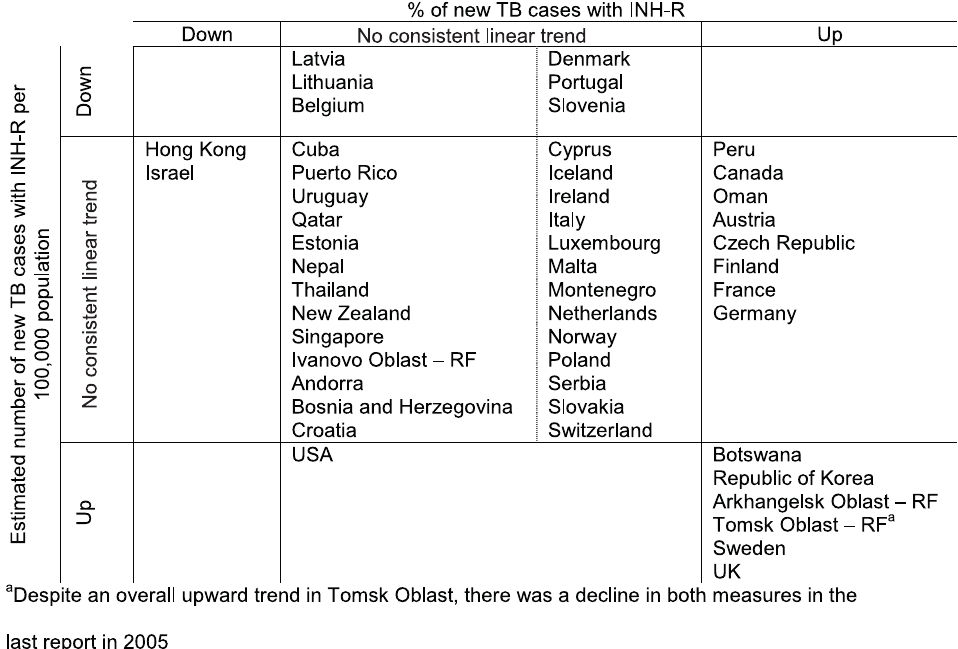
Figure 3. Linear trends in isoniazid resistance (INH-R) among new TB cases. We estimated trends in the percentage of new TB cases with INH-R and the estimated number of new TB cases with INH-R per 100,000 population. Settings are grouped by any linear trend (p , 0.1) found (‘‘down’’ or ‘‘up’’) or ‘‘no consistent linear trend’’ if no linear trend was found. RF=Russian Federation.